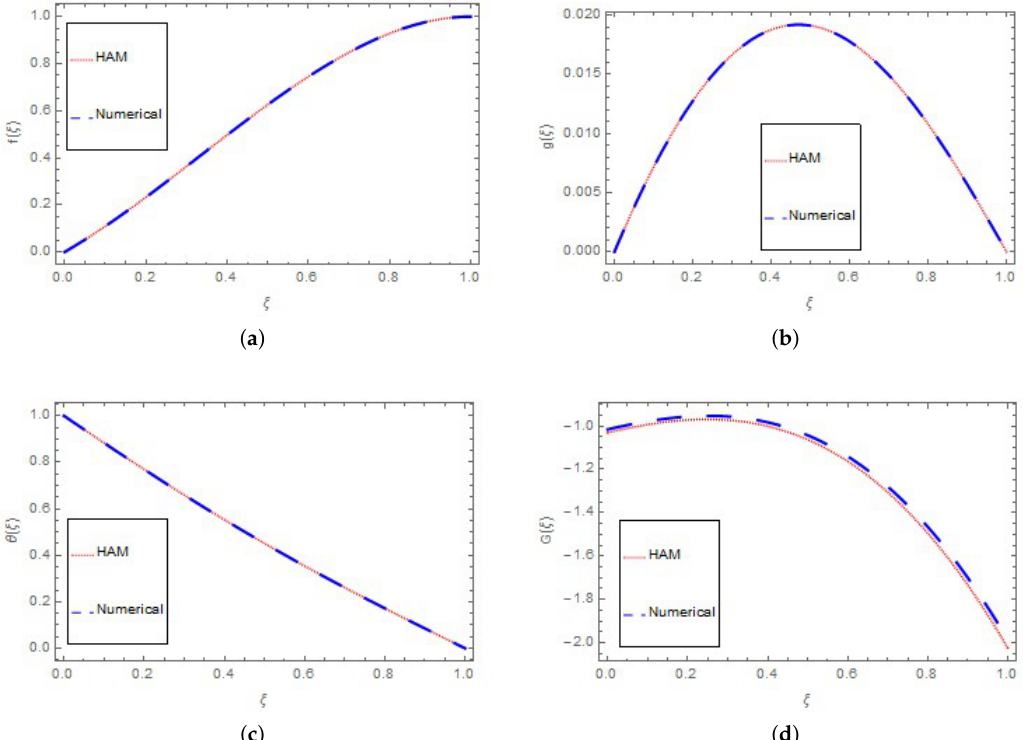
Figure 7. ( a ) Homotopy Analysis Method and Numerical method comparasion for f ( ξ ) ; ( b ) Homotopy Analysis Method and Numerical method comparasion for g ( ξ ) ; ( c ) Homotopy Analysis Method and Numerical method comparasion for θ ( ξ ) ; ( d ) Homotopy Analysis Method and Numerical method comparasion for G ( ξ )